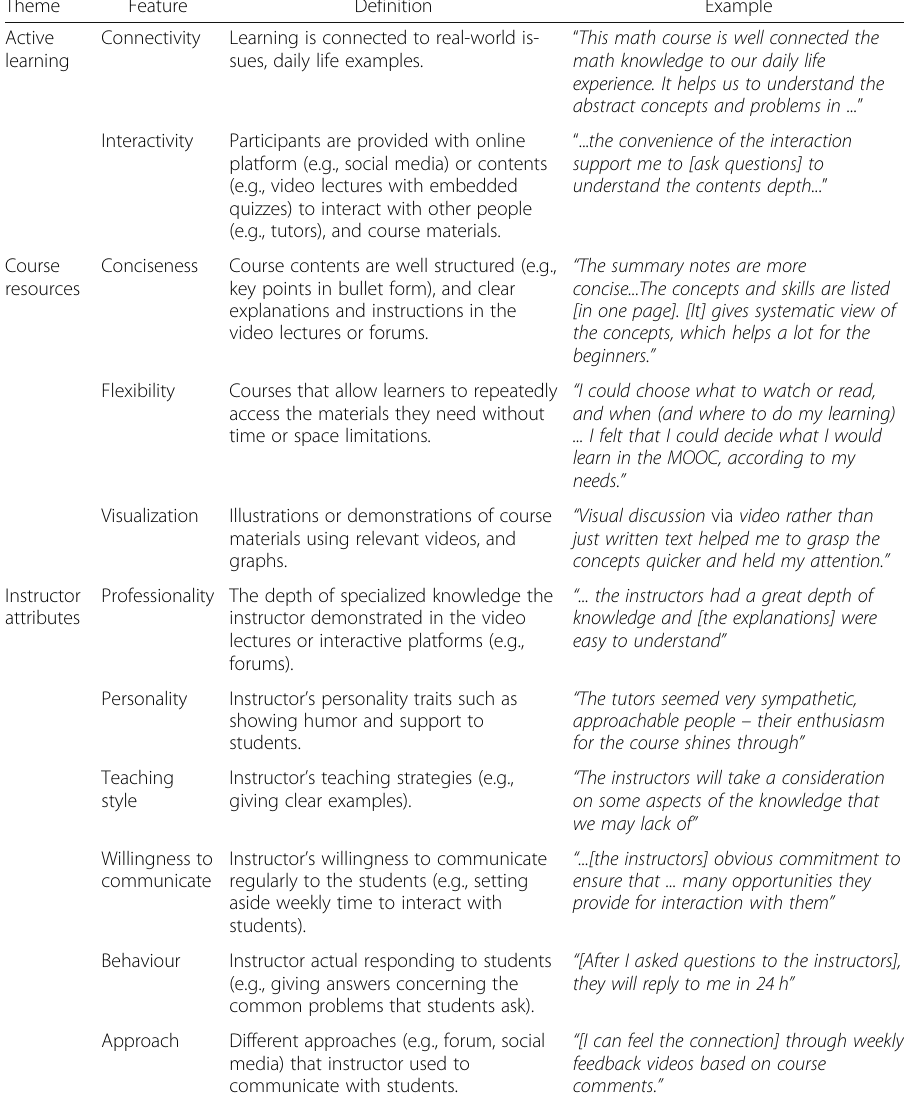
Table 8 Course design features promote learning